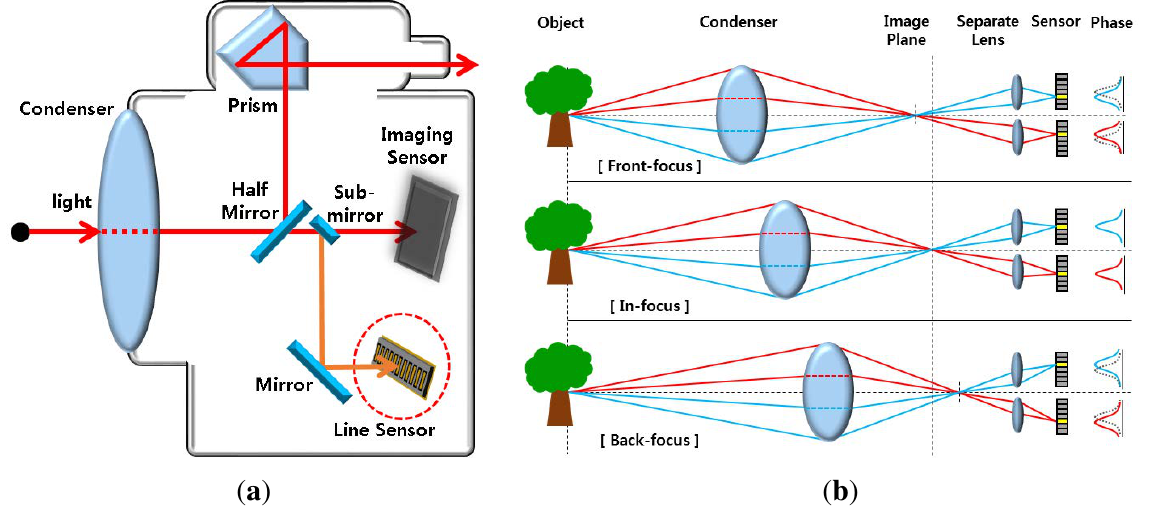
Figure 1. Phase-difference auto-focusing (PDAF) system: ( a ) light path in the camera with the PDAF system and ( b ) the concept of phase difference generated by two line